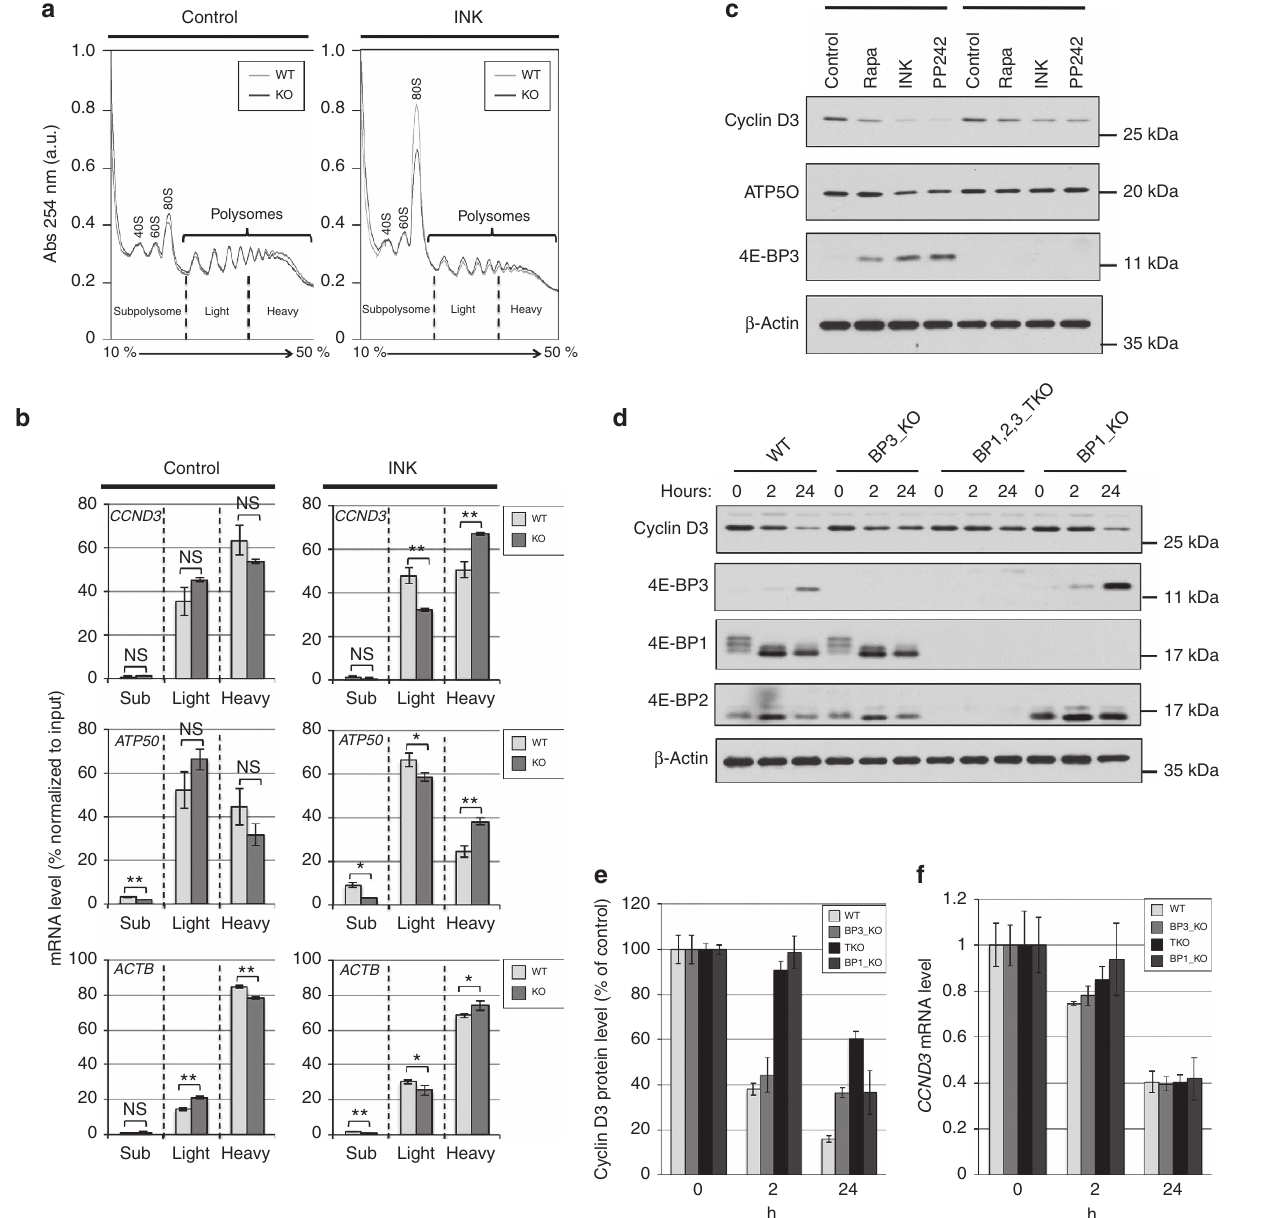
Figure 5 | 4E-BP3 regulates translation of eIF4E-target mRNAs under prolonged mTORC1 inhibition. ( a ) Polysome profiling in 4E-BP3 WT and KO MiaPaCa-2 cells. The cells were treated with 100nM INK1341 for 24h. ( b ) Abundance of each mRNA in heavy, light or subpolysomes was analysed by real- time PCR. Error bars indicate ± s.d. ( n ¼ 3). * P o 0.05 and ** P o 0.01. Statistical significance between WTand KO in each fraction (Sub, Light or Heavy) was determined using Student’s t -test. ( a , b ) A representative result of two independent experiments is shown. ( c ) The 4E-BP3 WTor KO MiaPaCa-2 cells were treated with the indicated mTOR inhibitors (Rapa 100nM, INK1341 100nM and PP242 1 m M) for 24h. Each protein expression was determined by immunoblotting. A representative result of three independent experiments is shown. ( d ) 4E-BP3 WT, KO, 4E-BP1,2,3 TKO or 4E-BP1 KO cells were treated with INK1341 (100nM), for 2 or 24h. Each protein expression was determined by immunoblotting. A representative result of two independent experiments is shown. ( e ) Cyclin D3 protein expression was quantified by densitometry analysis using ImageJ and normalized by b -Actin level. Error bars indicate ± s.d. ( n ¼ 3). ( f ) CCND3 mRNA level was analysed by real-time PCR. Error bars indicate ± s.d. ( n ¼ 3). A representative result of three or two independent experiments is shown.